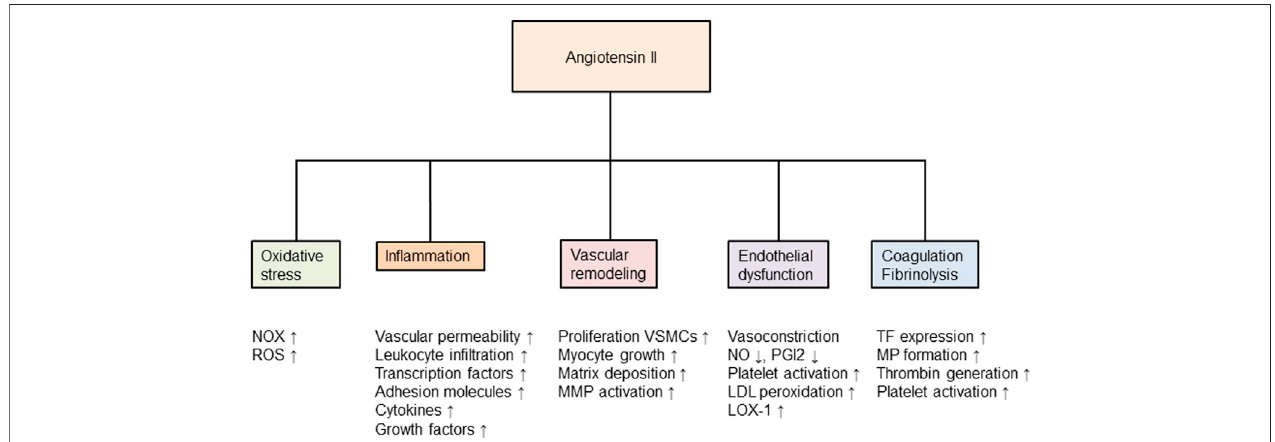
FIGURE1| AngiotensinIIandits effects inthedevelopmentofatherosclerosis.Nox,nicotinamide-adenine dinucleotidephosphate oxidase;ROS,reactiveoxygen species; MMP, matrix metalloproteinase; VSMCs, vascular smooth muscle cells; NO, nitric oxide; PGI2, prostaglandin I 2 (also called prostacyclin); LDL, low-density lipoprotein; LOX, lectin-like oxidized low-density lipoprotein receptor; TF, tissue factor; MP, microparticles and tPA, tissue plasminogen activator. Modi fi ed from (Volpe,